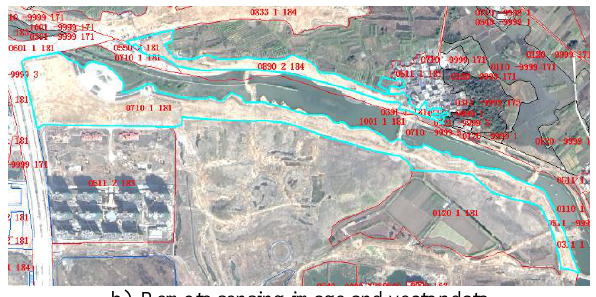
Figure 6. Other construction sites (0839) were mistakenly collected as hardened ground (0710)